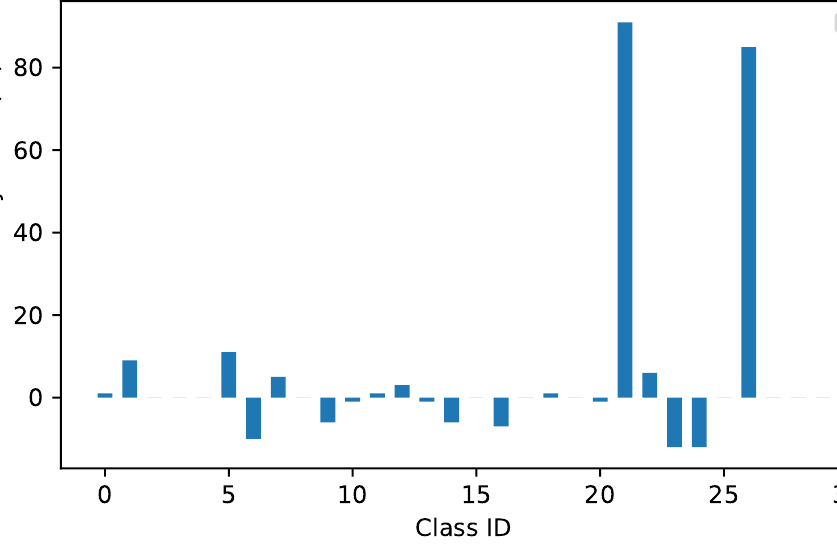
Figure 10. Precision comparison for each class of our proposed method and the MixMatch method on AID dataset, where the Y-axis denotes per class classification accuracy improvement of our proposed method relative to MixMatch, and the X-axis denotes the class index of each